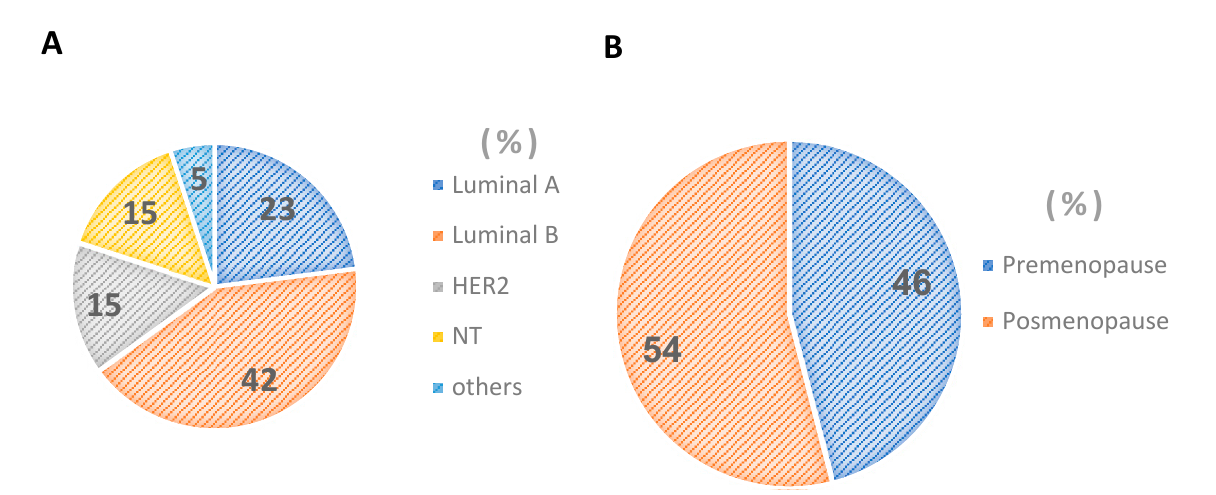
Figure 1. Percentage distribution of molecular types of breast cancer in Mexican women ( A ). Per- centage stage menopause breast cancer in Mexican women ( B ).